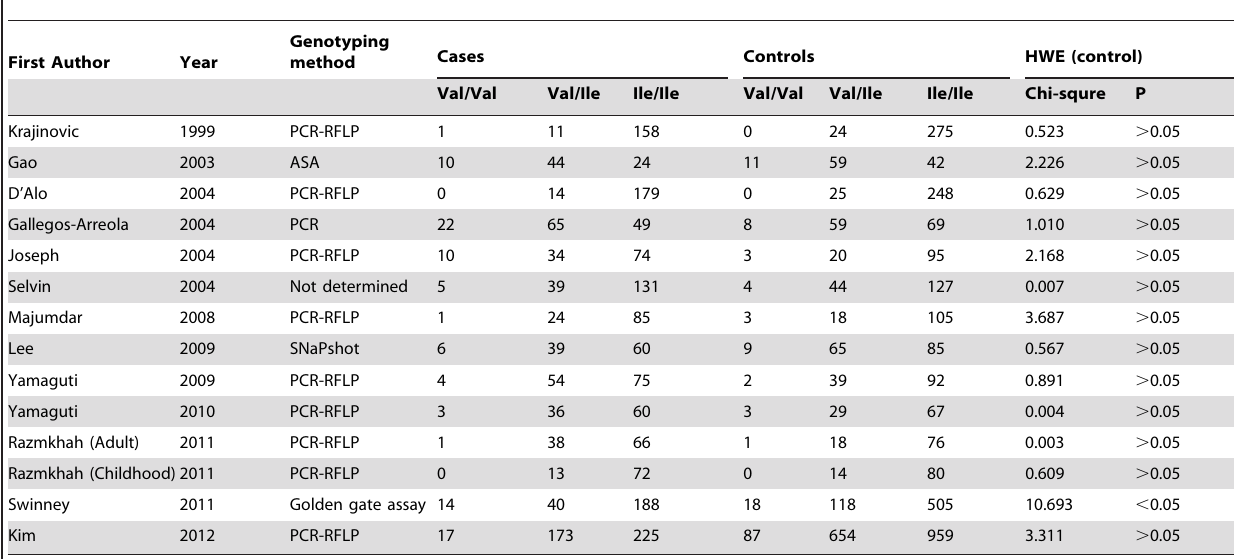
Table 2. Distribution of CYP1A1 Ile462Val genotype among acute leukemia cases and controls included in the meta-analysis.